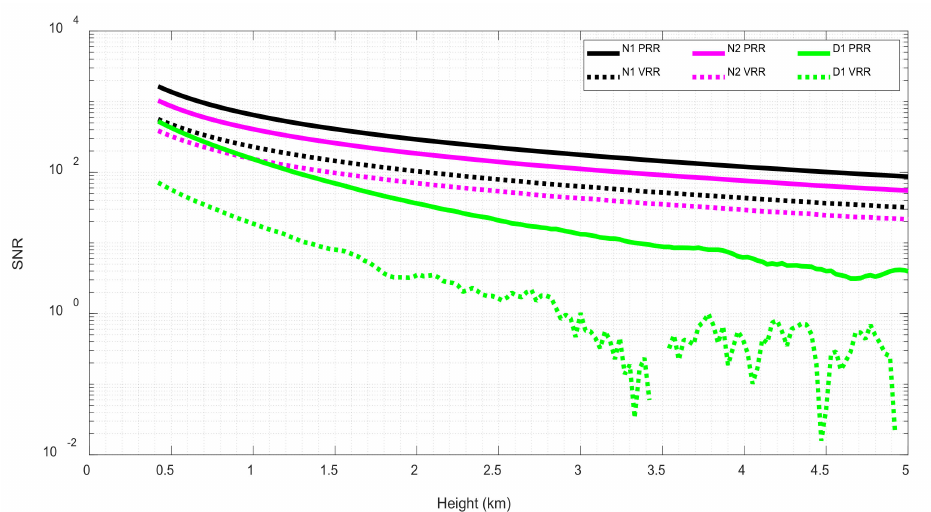
Figure 7. PRR and VRR Signal-to-noise